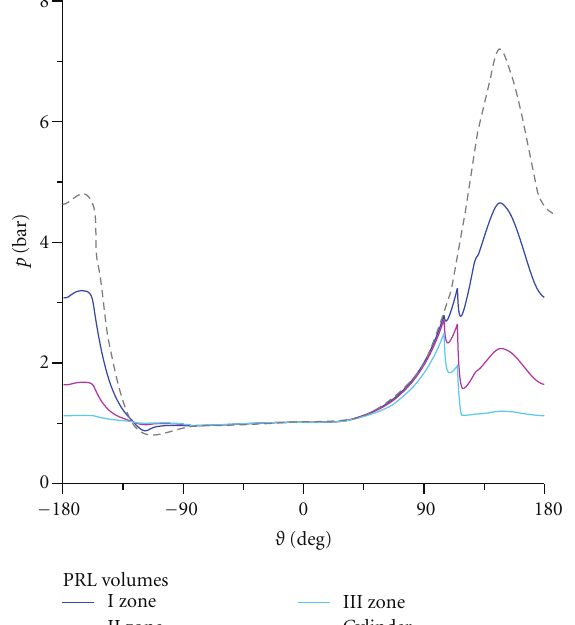
Figure 16: Pressure analysis in PRL volumes, β = 5, stable